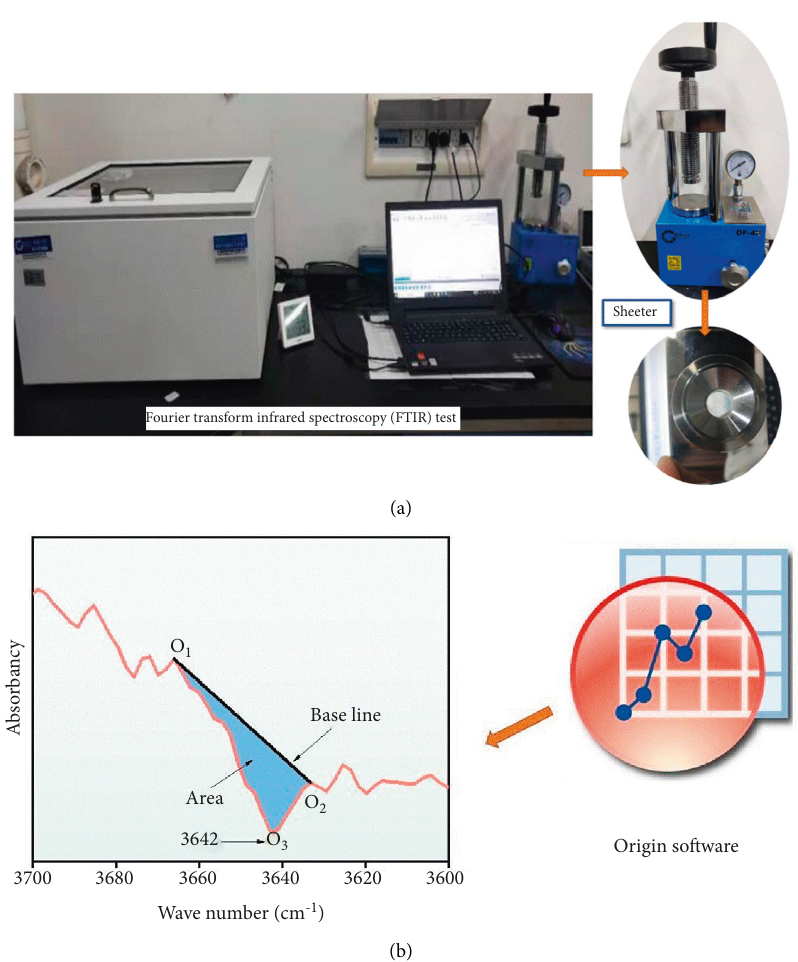
Figure 5: FTIR test: (a) process of preparation of thin slice samples; (b) calculation of peak area of Ca(OH)